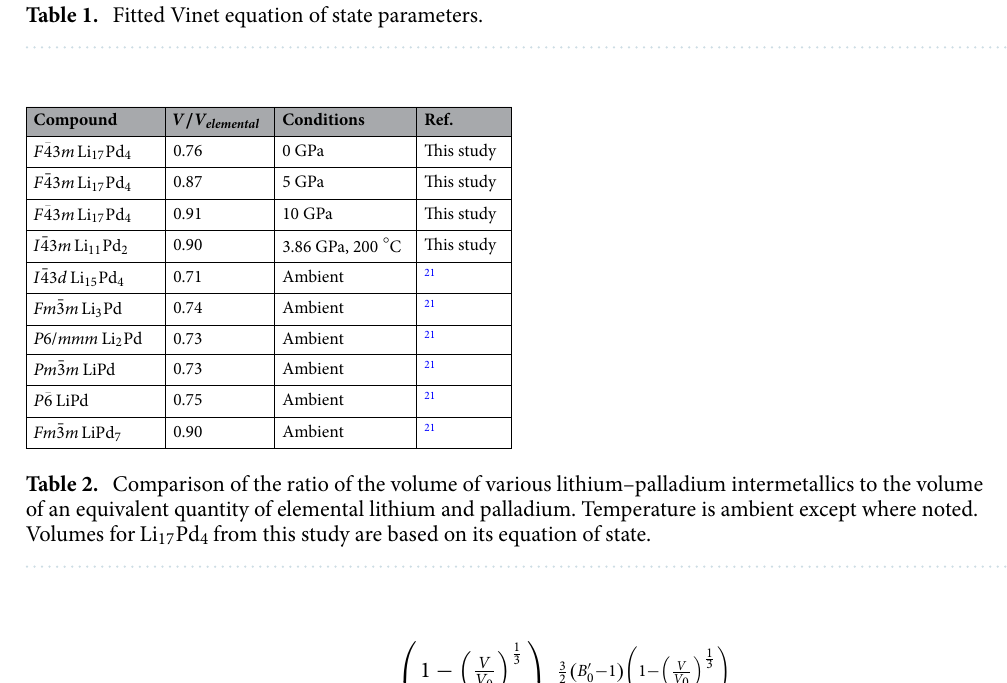
Table 1. Fitted Vinet equation of state parameters.